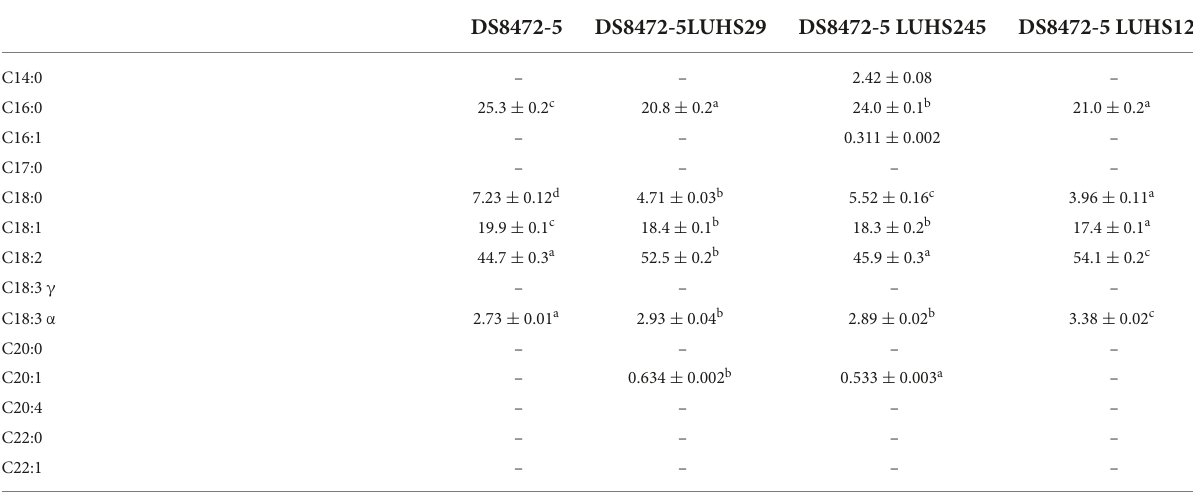
TABLE 2 Fatty acid (FA) profiles of wheat cereal wholemeal (WCW) (DS8472-5) samples. Fatty acid concentration, % of total fat